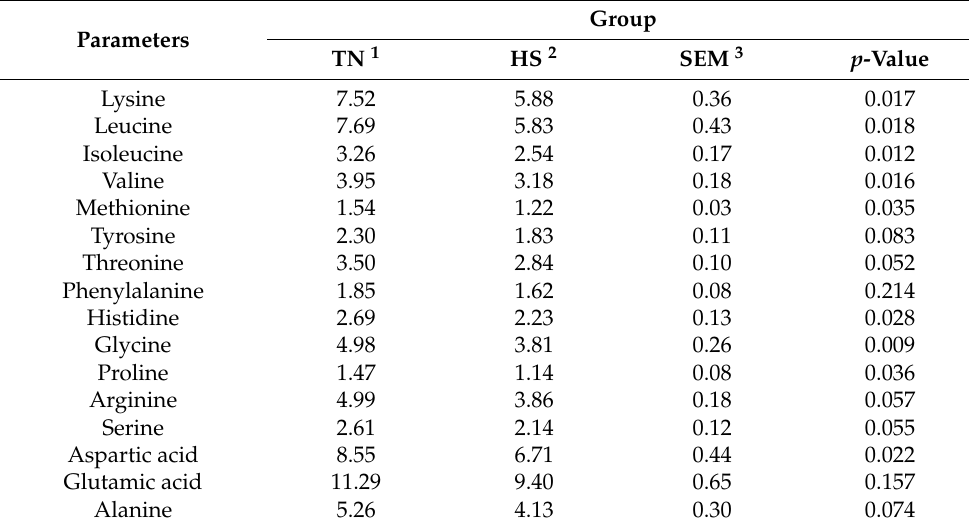
Table 4. Effect of chronic heat stress on amino acid profile (g/100 g) of breast muscles in broiler chickens.